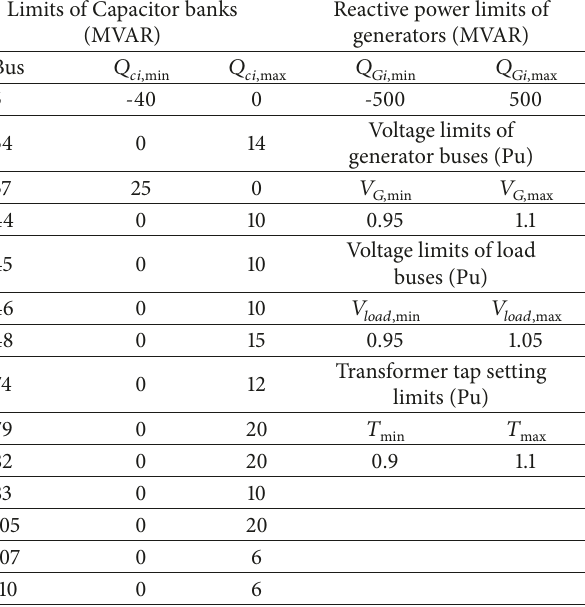
Table 13: Setting limits for IEEE 118-bus